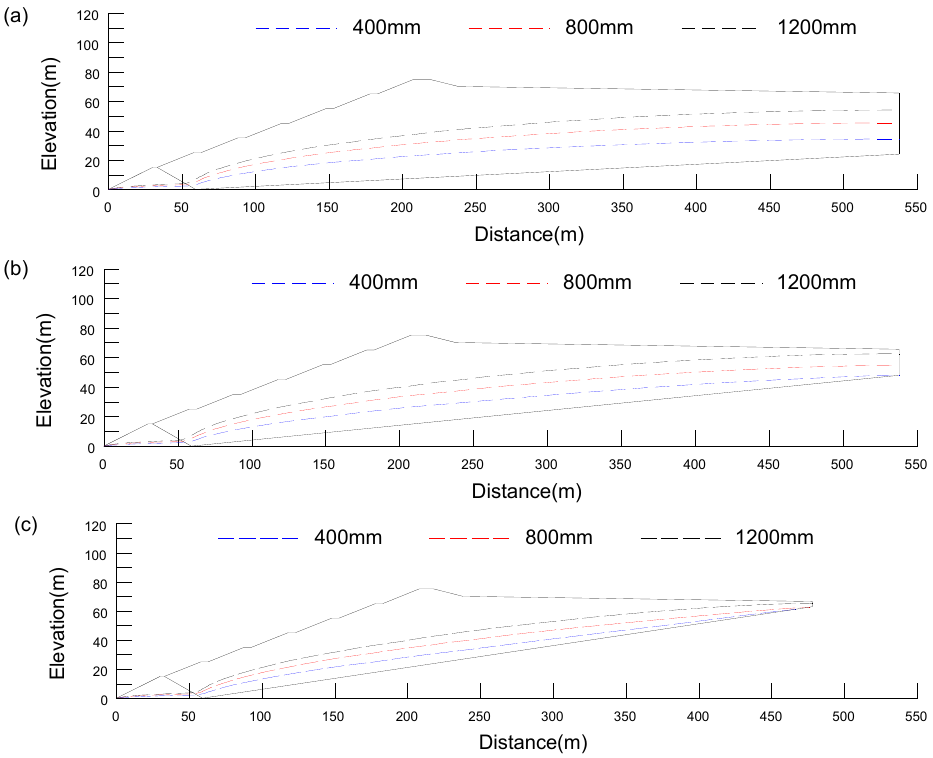
Figure 11. Effects of annual rainfall: ( a ) i = 0.05; ( b ) i = 0.1; ( c ) i = 0.15.